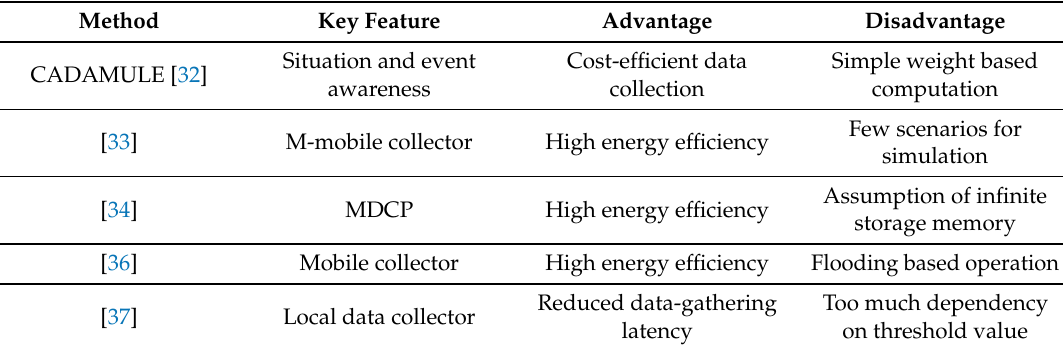
Table 3. Comparison of advantages and disadvantage for data